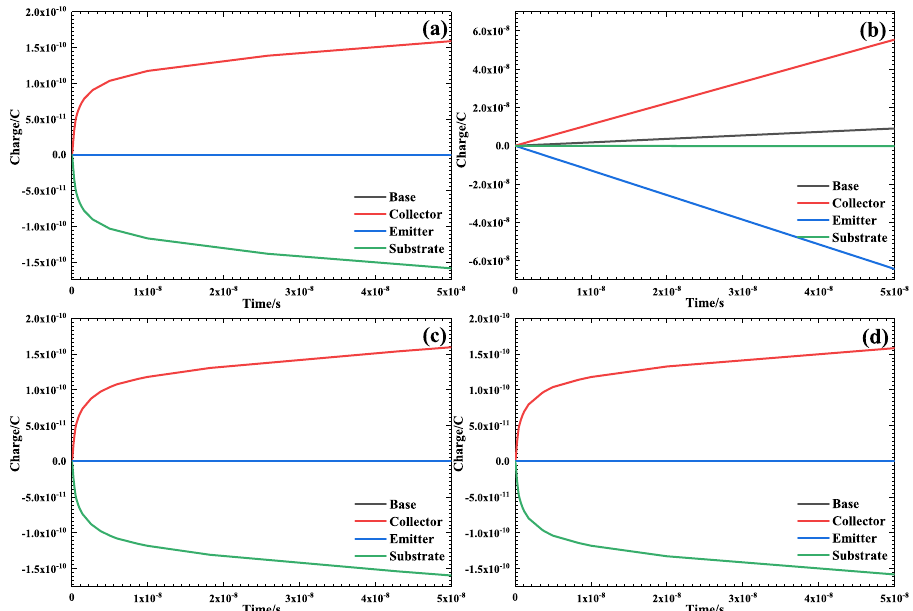
Figure A6. Change in collected charge with time when heavy ions vertically irradiate the emitter of the SiGe HBT under the substrate inverse bias ( a ), positive bias ( b ), off bias ( c ) and collector positive bias ( d )